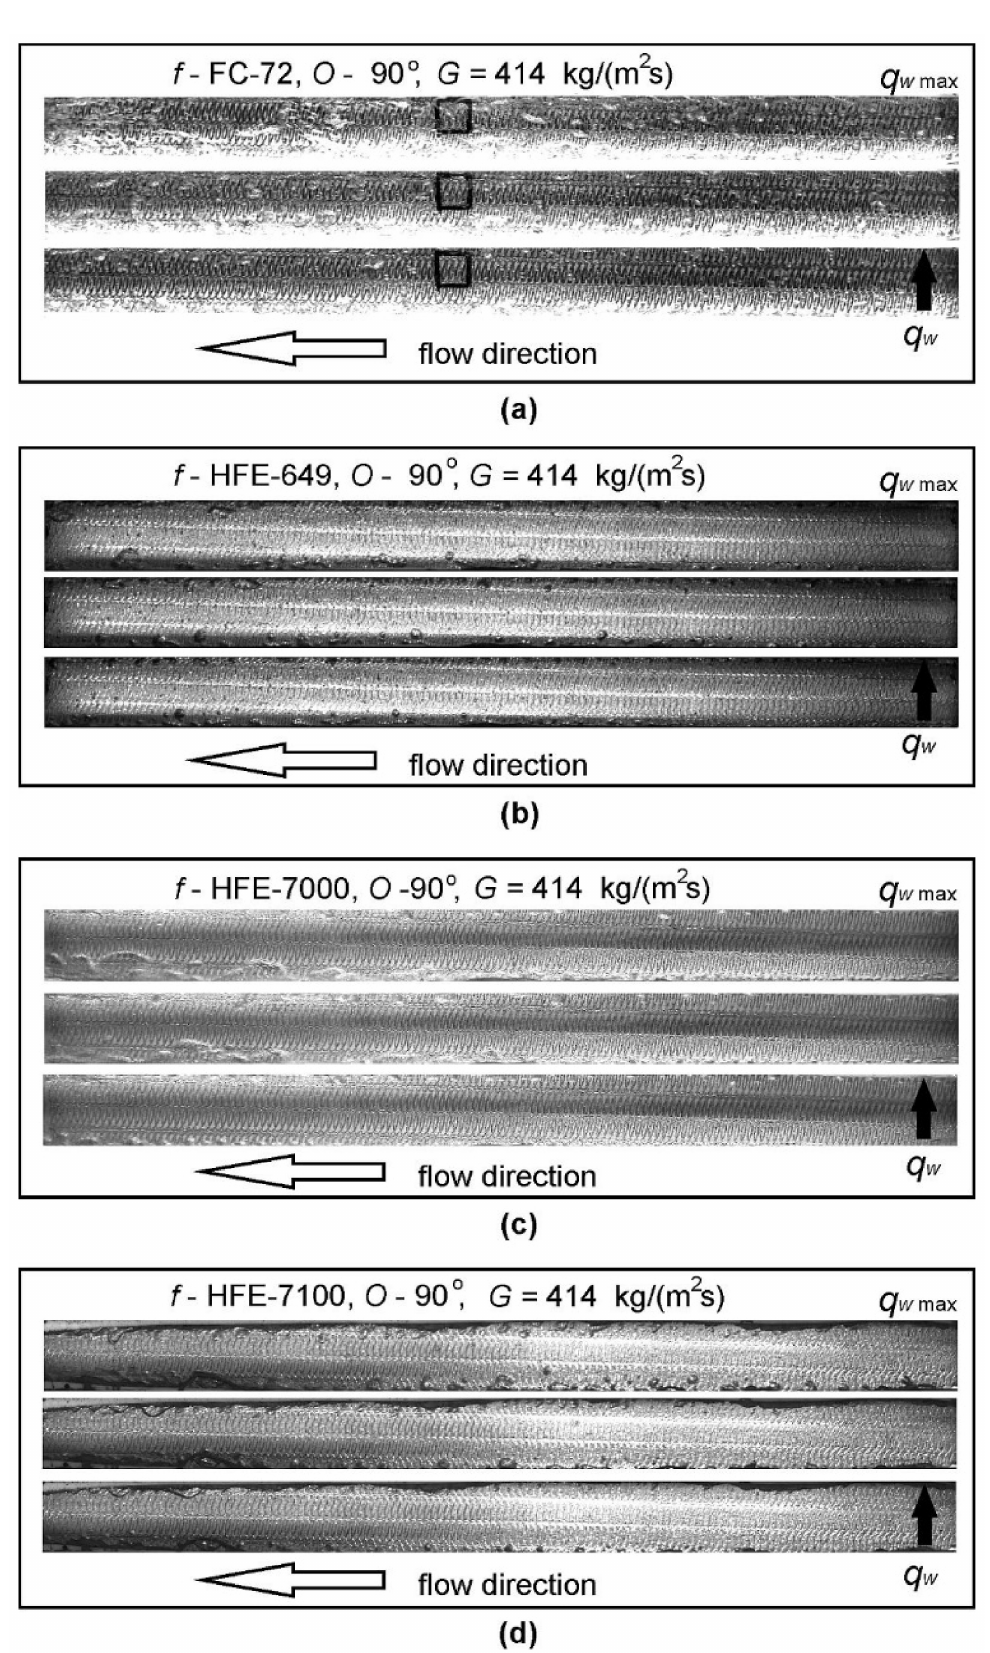
Figure 14. Images of two-phase flow structures recorded for: various refrigerants, constant mass flux, vertical channel orientation (90 ◦ ), modified heated plate surface (vibration-assisted laser surface texturing No. 2), L IRT = 180